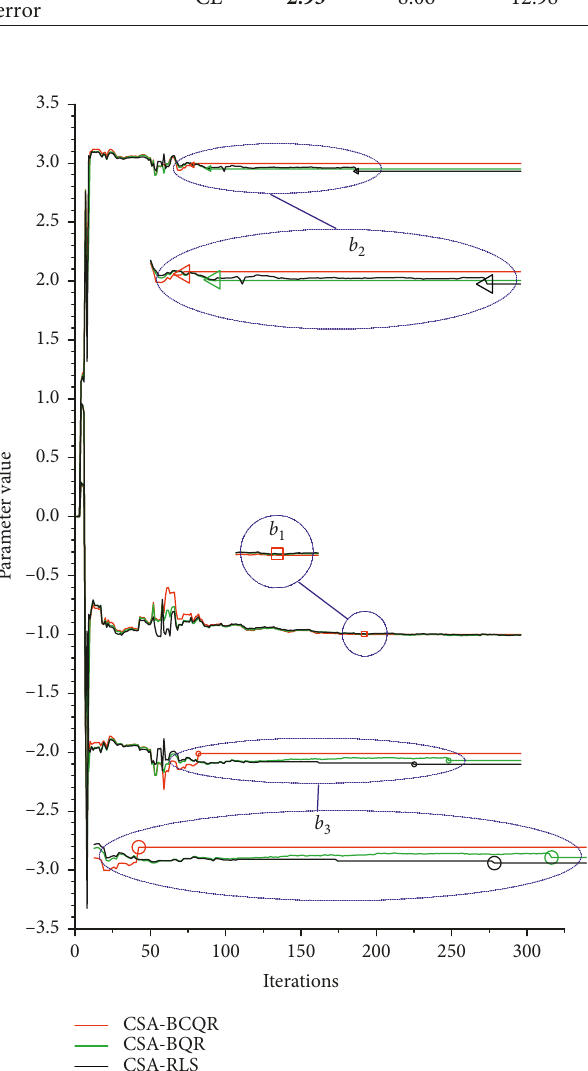
Figure 4: Parameter identification results of the linear